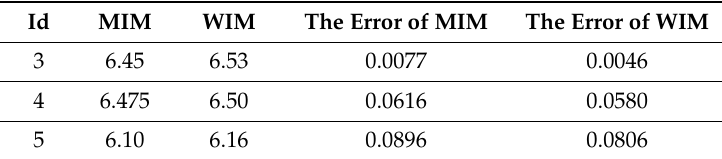
Table 2. The interpolation results of SOF2.